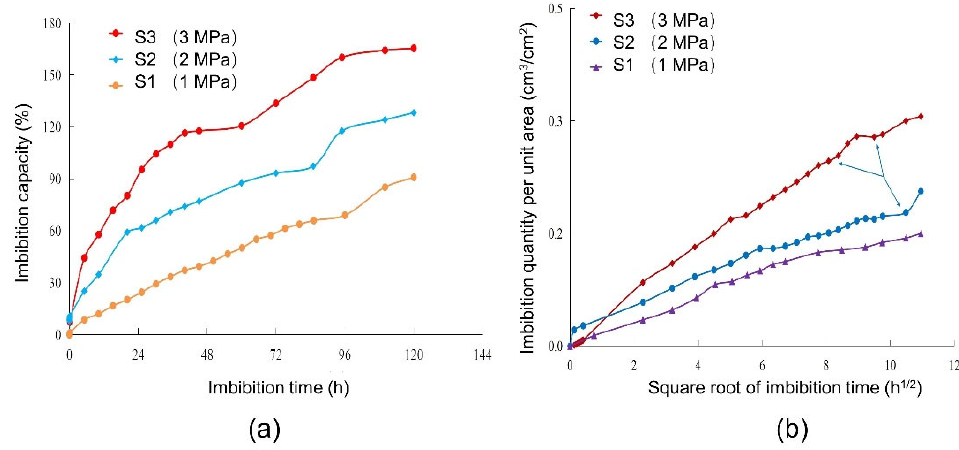
Figure 10. Comparison of forcible imbibition capacity and imbibition quantity under different con ‐ fining pressures.